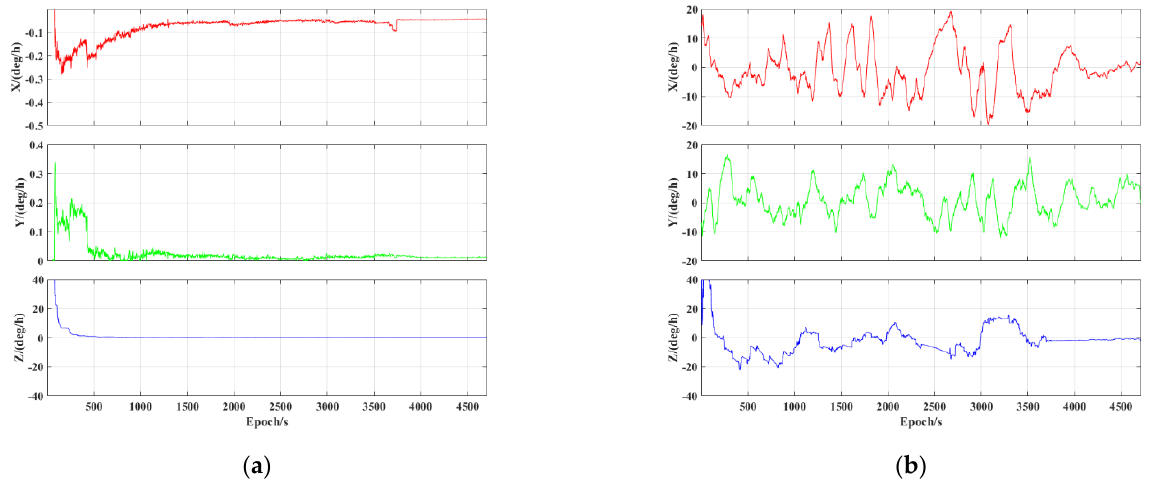
Figure 13. The gyro biases estimation errors of the two IMUs: ( a ) tactical IMU; ( b ) MEMS IMU.